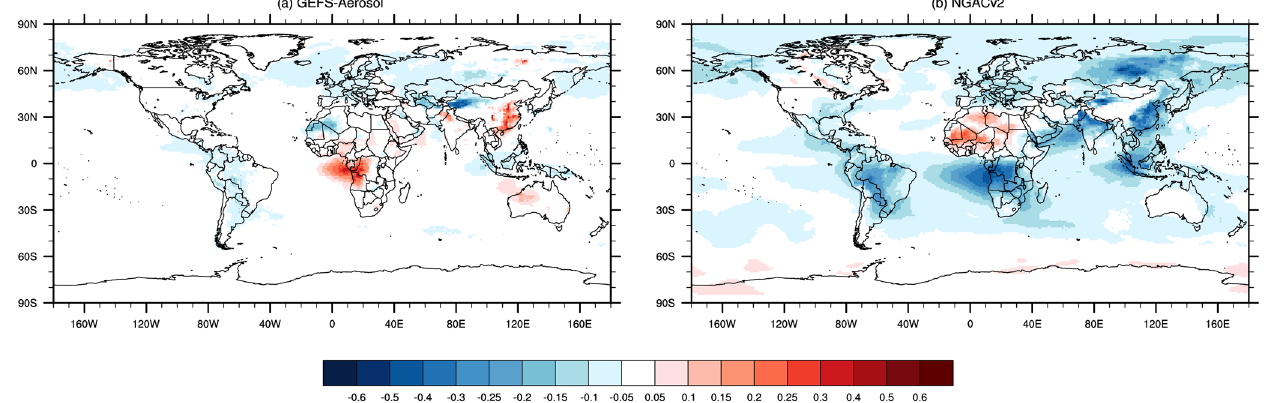
Figure 8. Differences of GEFS-Aerosols and NGACv2 Day-1 predictions of total AOD compared to MERRA-2 reanalysis averaged during 5 July–30 November